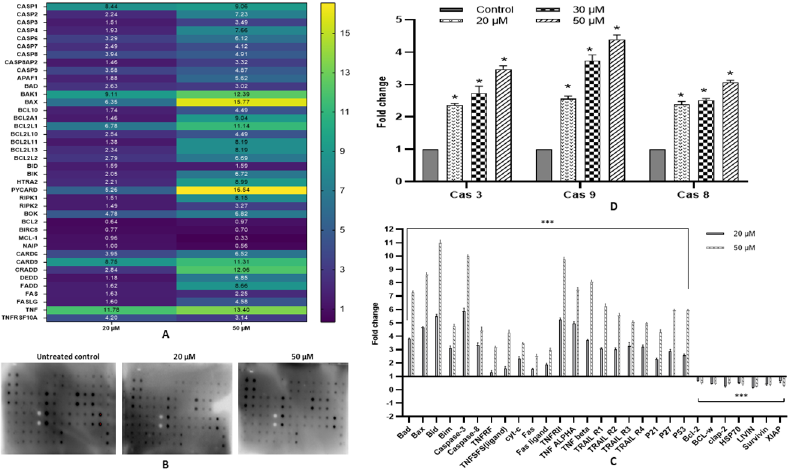
Figure 4. Expression analysis. ( A ). Heat map showing the expression of various genes involved in apoptosis. RQ plot of caspases, extrinsic receptors and ligands, pro-apoptotic gene and anti-apoptotic after fisetin treatment at 20 µM and 50 µM for 48 h. ( B ) Images of nitrocellulose proteome profiler showing differential expression of the regulatory pathway and apoptotic proteins in the control and fisetin-treated sample (20 and 50 µ M of fisetin for 48 h). ( C ) Graphical representation of protein expression as fold change compared with the control sample. Fisetin treatment increased pro-apoptotic while decreasing the expression of anti-apoptotic proteins [* p ≤ 0.05, *** p < 0.001]. ( D ) Evaluation of caspase 3, caspase 8 and caspase 9 activity of fisetin-treated HeLa cells at 20, 30 and 50 µ M for 48 h. Graph represents an increase in the fold change in caspase 3, 8 and 9 activity compared with the